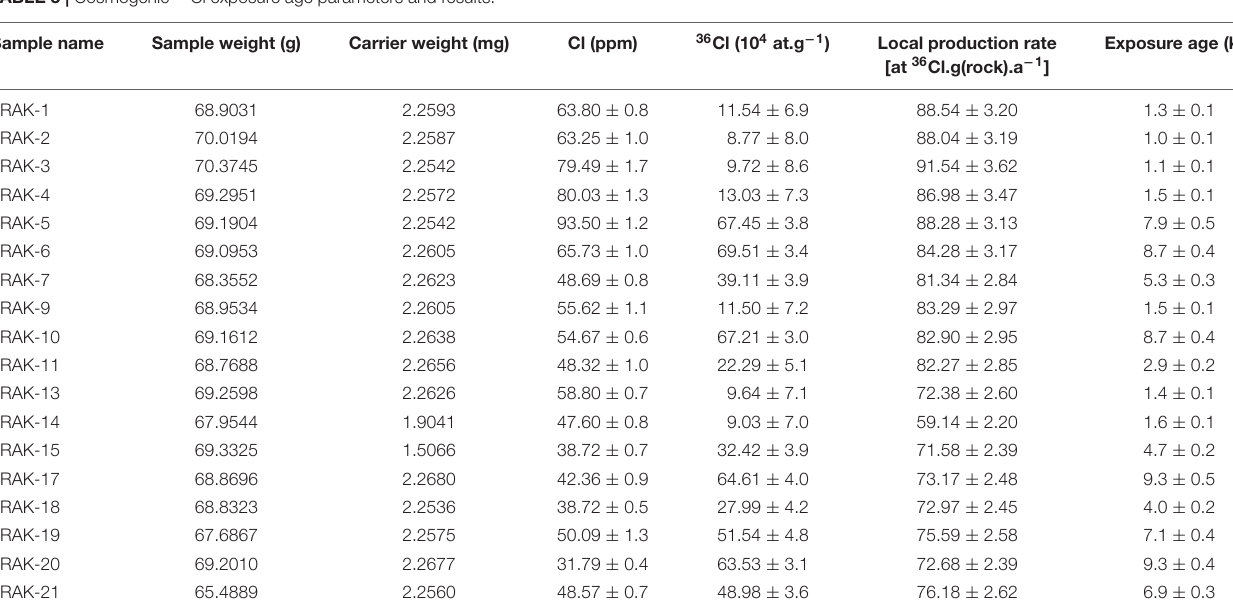
TABLE 3 | Cosmogenic 36 Cl exposure age parameters and